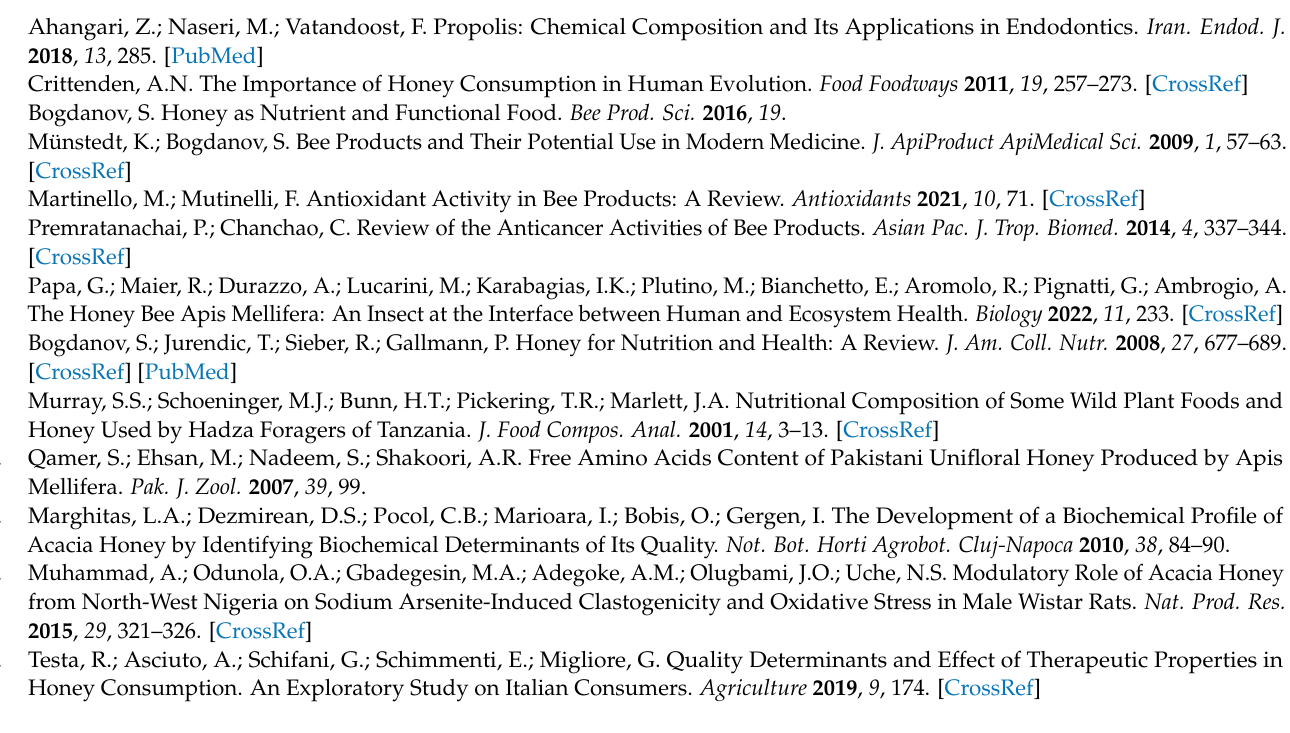
Table S2: Statistical significance analysis of the variation in the use of bee products other than honey for cosmetic and medicinal purposes (Chi 2